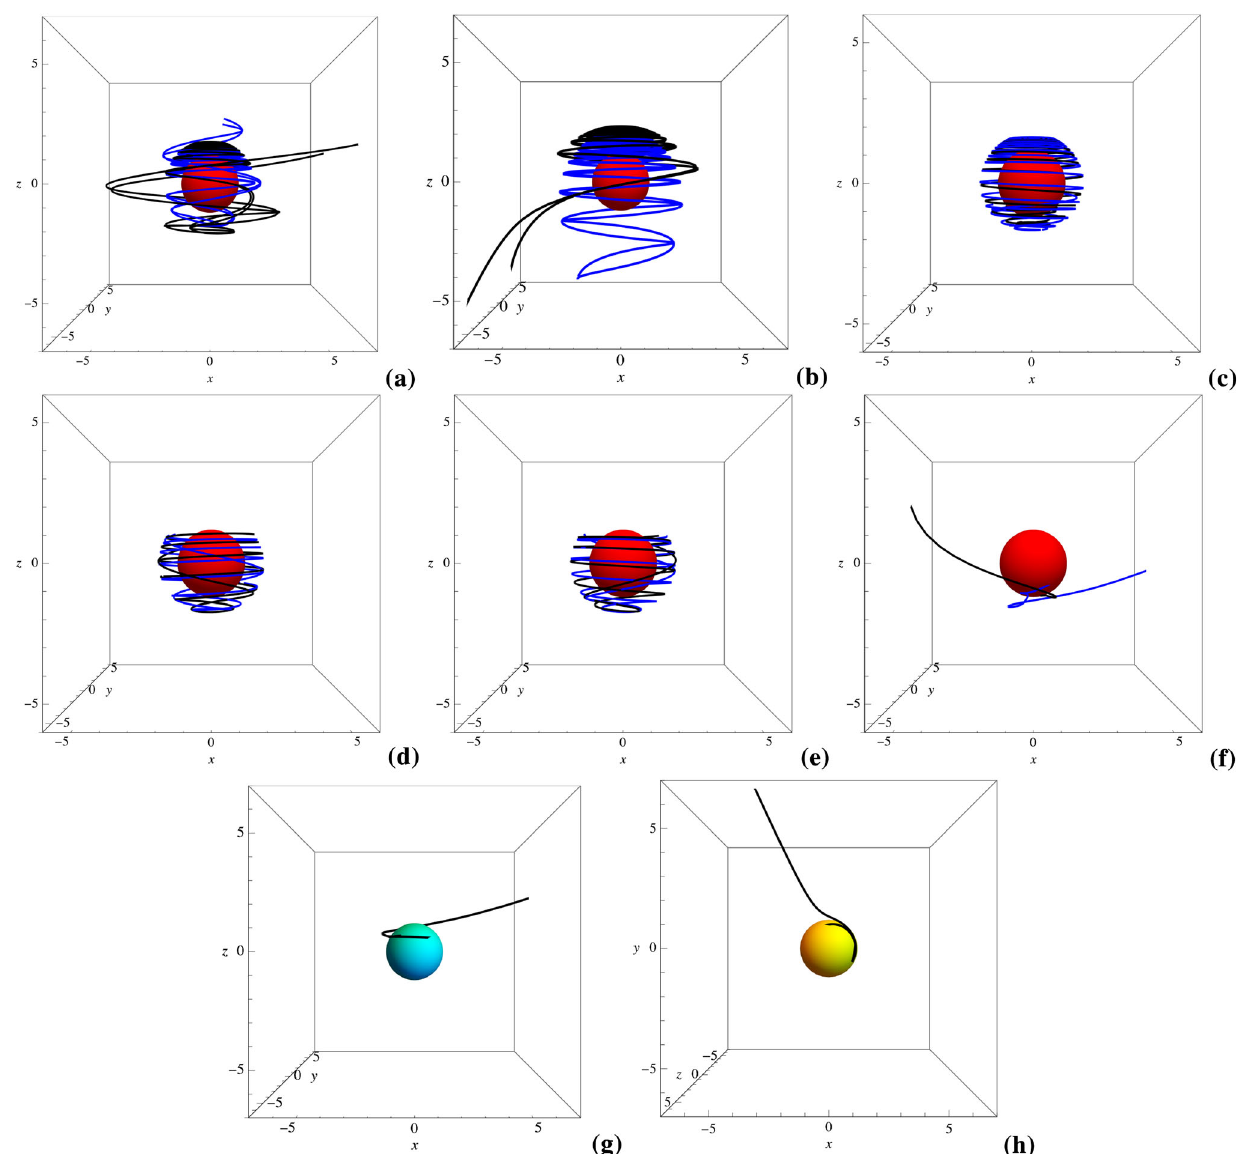
Fig. 13 The three-dimensional simulations of the possible orbits plot- ted for Q = 9 M 2 , corresponding to the three cases of ˜ η > 0 (a-f) where the black trajectories have been calculated for f r = f θ = 1 M 2 and the blue ones indicate the null trajectories in the vacuum Kerr spacetime (i.e. for f r = f θ = 0), ˜ η = 0 (g), and ˜ η < 0 (h). The sphere in the mid-